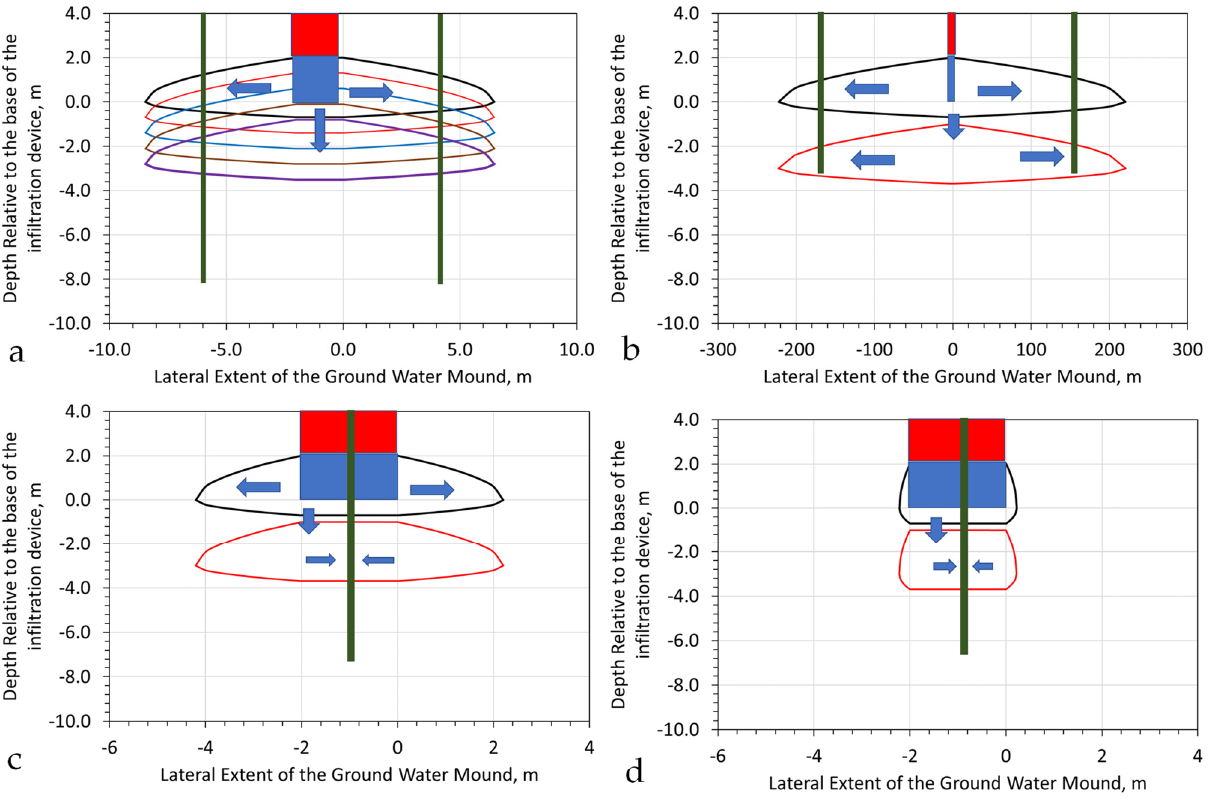
Figure A22. Remediation strategies associated with contaminated soils using groundwater mounds.